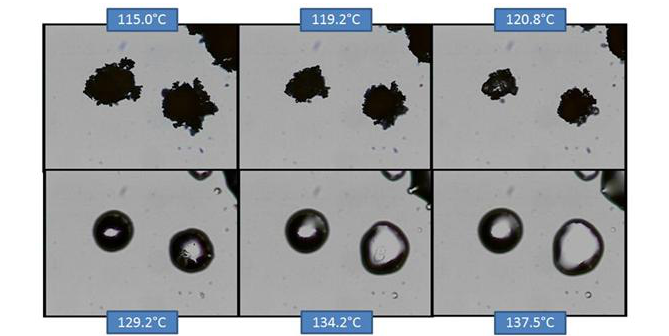
Figure 11. HSM of co-micronized EFV:PVP